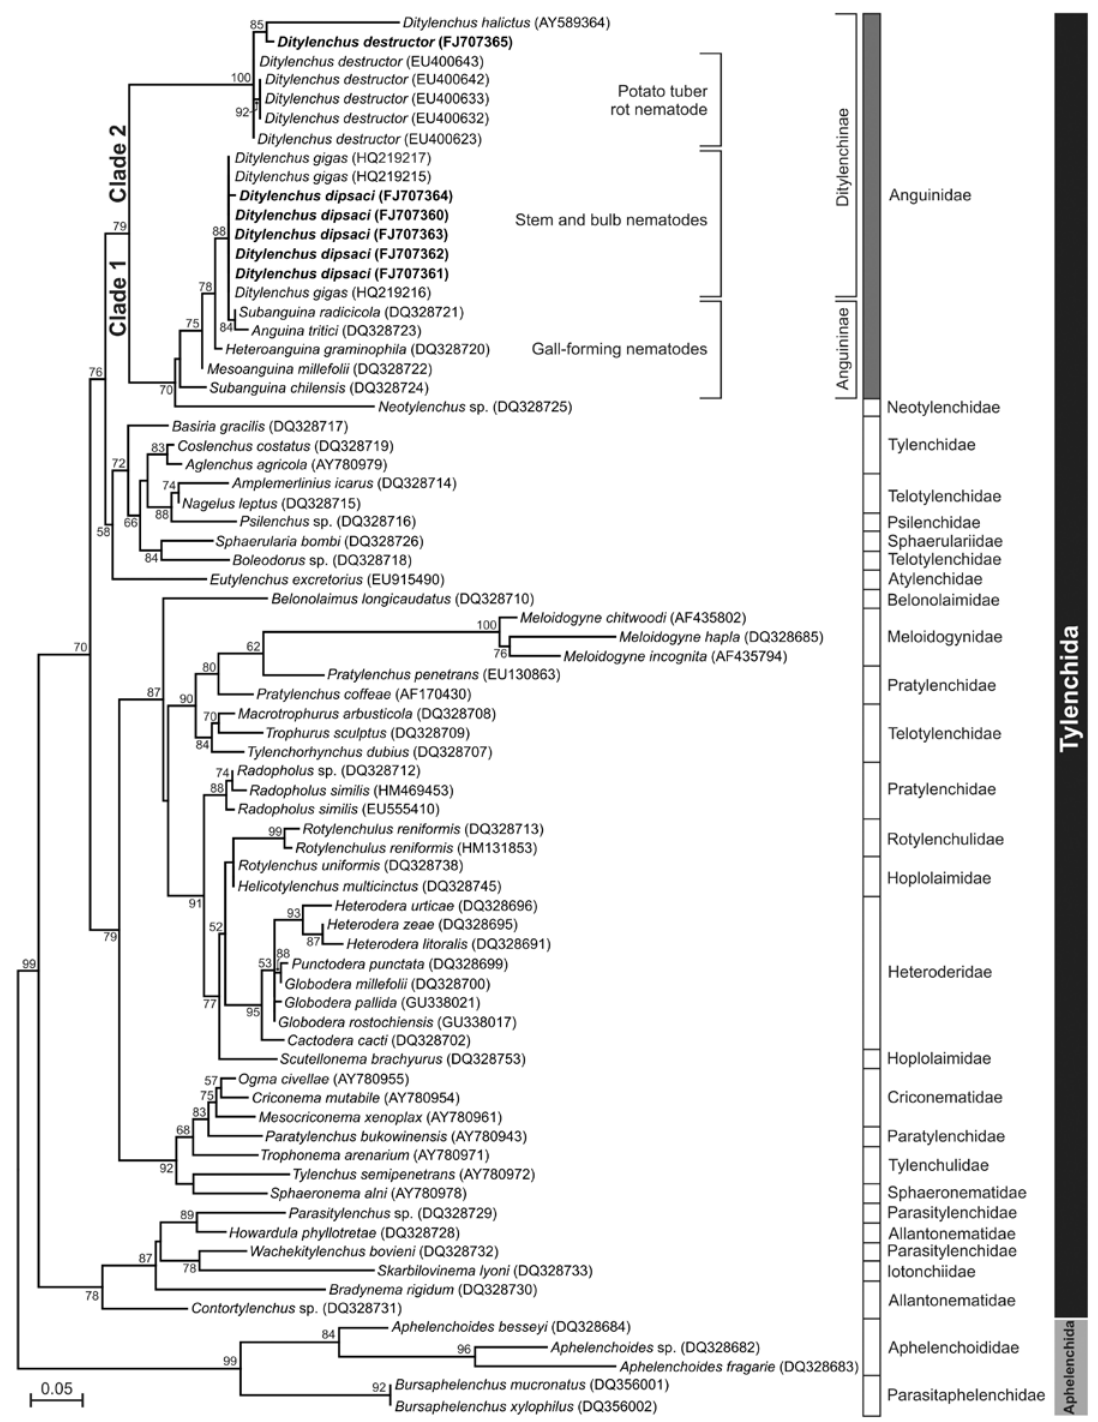
Figure 6. Unrooted maximum likelihood tree inferred from the D2-D3 LSU-rDNA sequence data for selected nematode species of the orders Tylenchida and Aphelenchida. Values at branches denote percentual bootstrap values (out of 500 replicates). The numbers in brackets indicate the GenBank accession. Newly sequenced species are indicated in bold